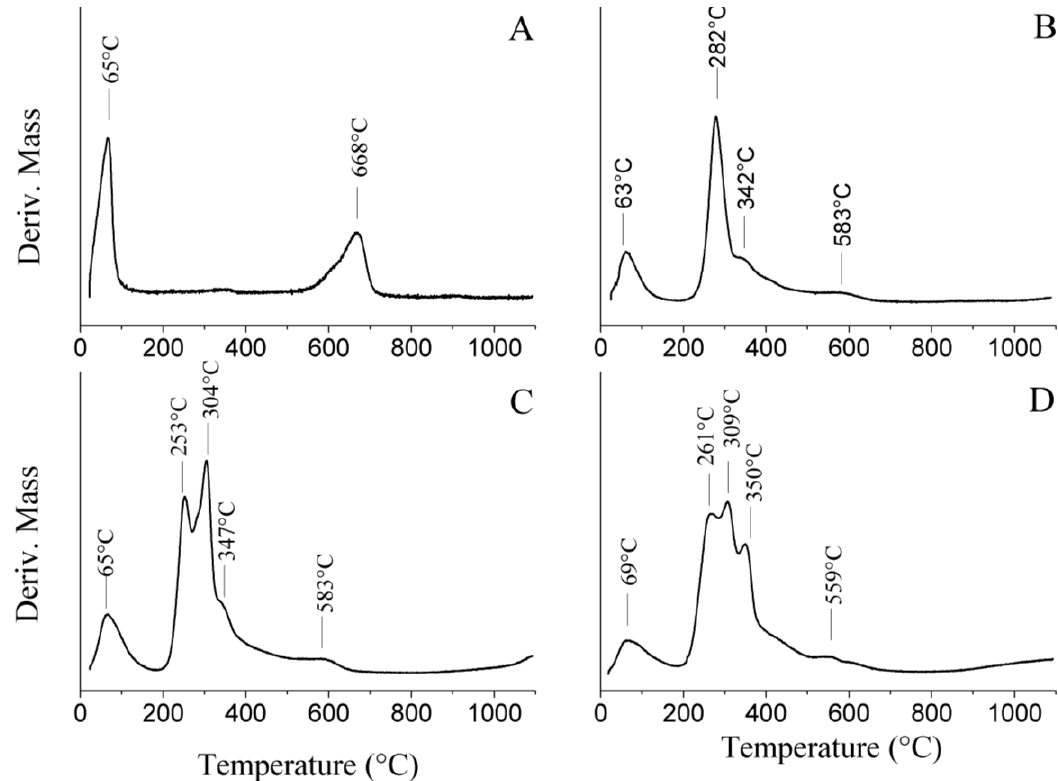
Figure 8. Differential thermal gravimetric (DTG) traces of ( A ) Na + MMT; ( B ) CG-MMT 3:1; ( C ) NG-MMT 3:1; and ( D ) NG-MMT